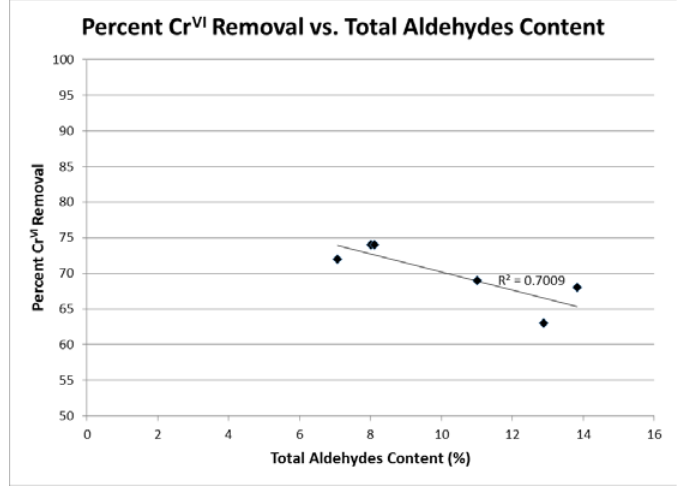
Figure 4. Percent Cr VI removal versus total aldehydes content. Figure 5. Percent Cr VI removal versus humic/fulvic acids